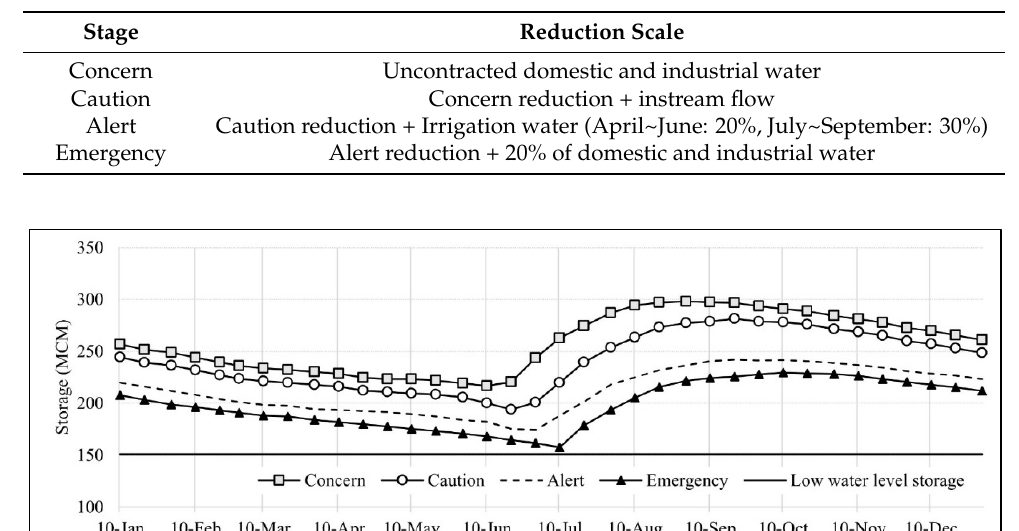
Figure 2. Description of multipurpose reservoir storage zones and water levels. The water in emer- gency storage is unavailable for water supply during the normal seasons. However, the water in the emergency storage (above the emergency outlet) becomes available for emergency water use and supplies water only during emergency events (e.g., extreme drought).